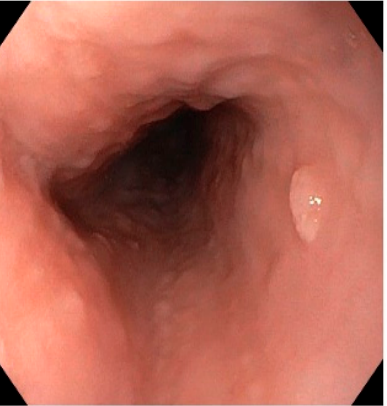
Figure 4. An endoscopic view of a typical esophageal papilloma (by courtesy of Prof. Matti Es- kelinen, University of Eastern Finland, Kuopio). University of Eastern Finland,